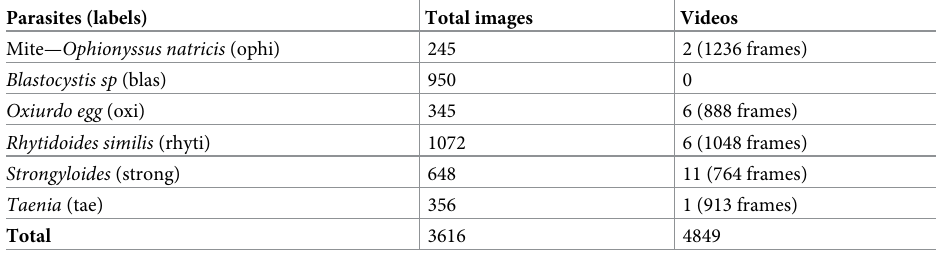
Table 1. Parasites database